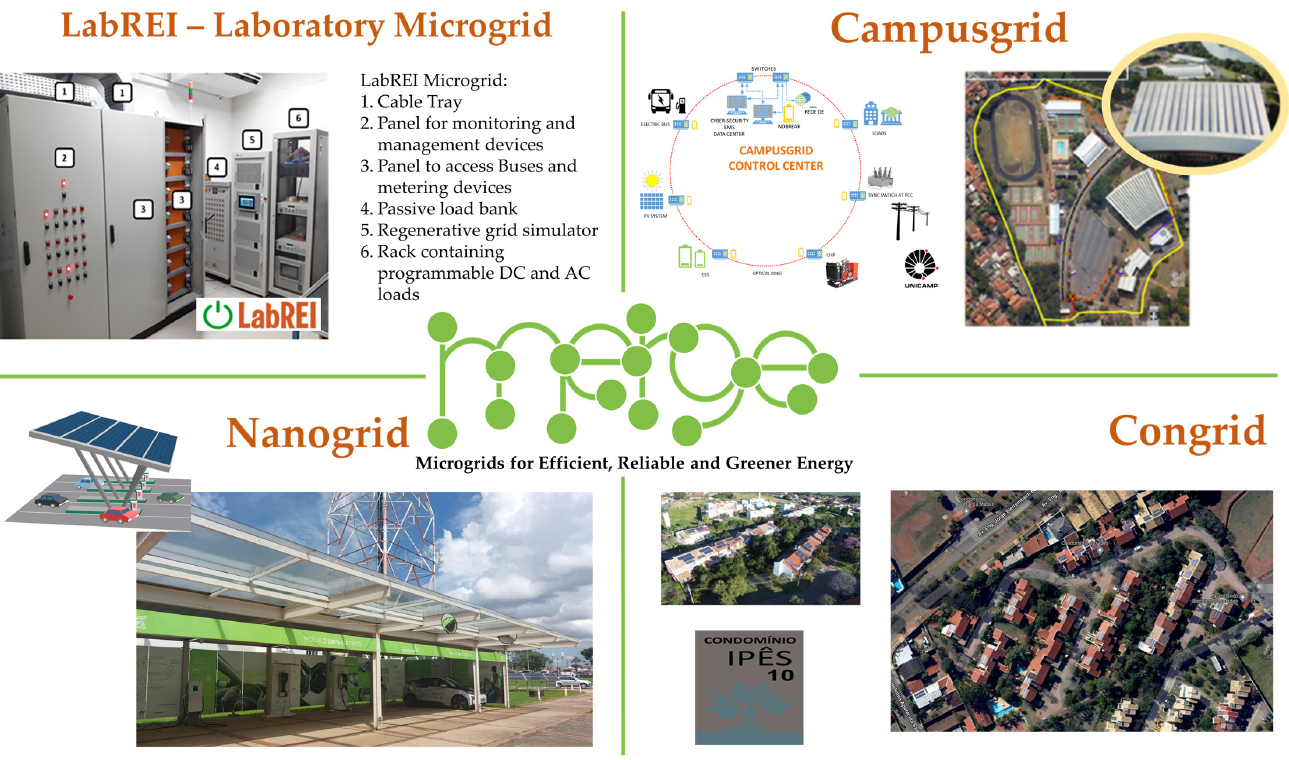
Figure 2. MERGE (Microgrid for Efficient, Reliable and Greener Energy) project microgrids— Nanogrid, Congrid, and Campusgrid.